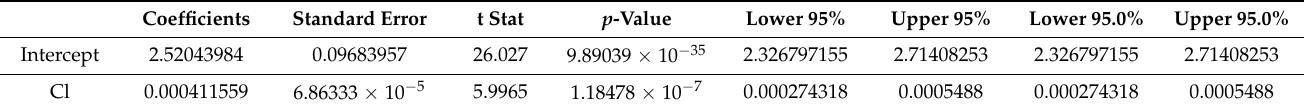
Table 10. Regression statistics and confidence